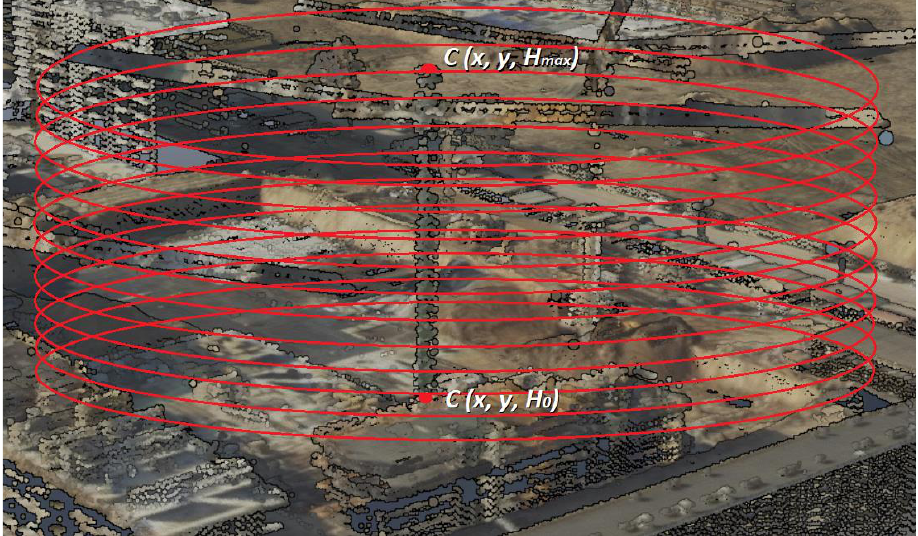
Figure 13. Classification of construction crane point cloud.